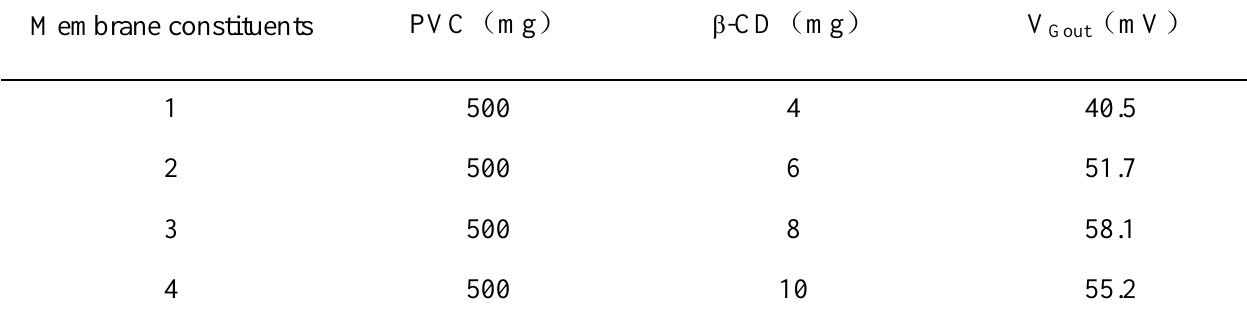
Table 1. The influence of the β -CD